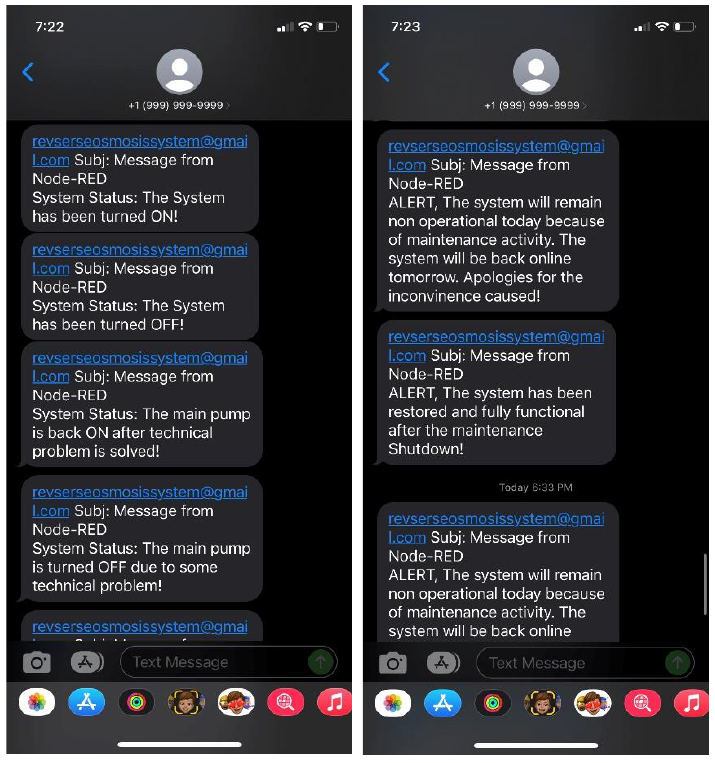
Figure 16. System status and alert messages received on a mobile phone.